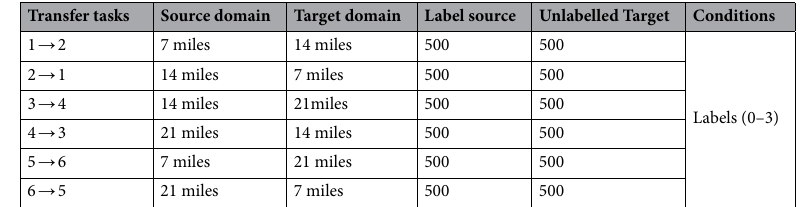
Table 4. Designed transfer tasks II across diverse severity levels (0 hp).